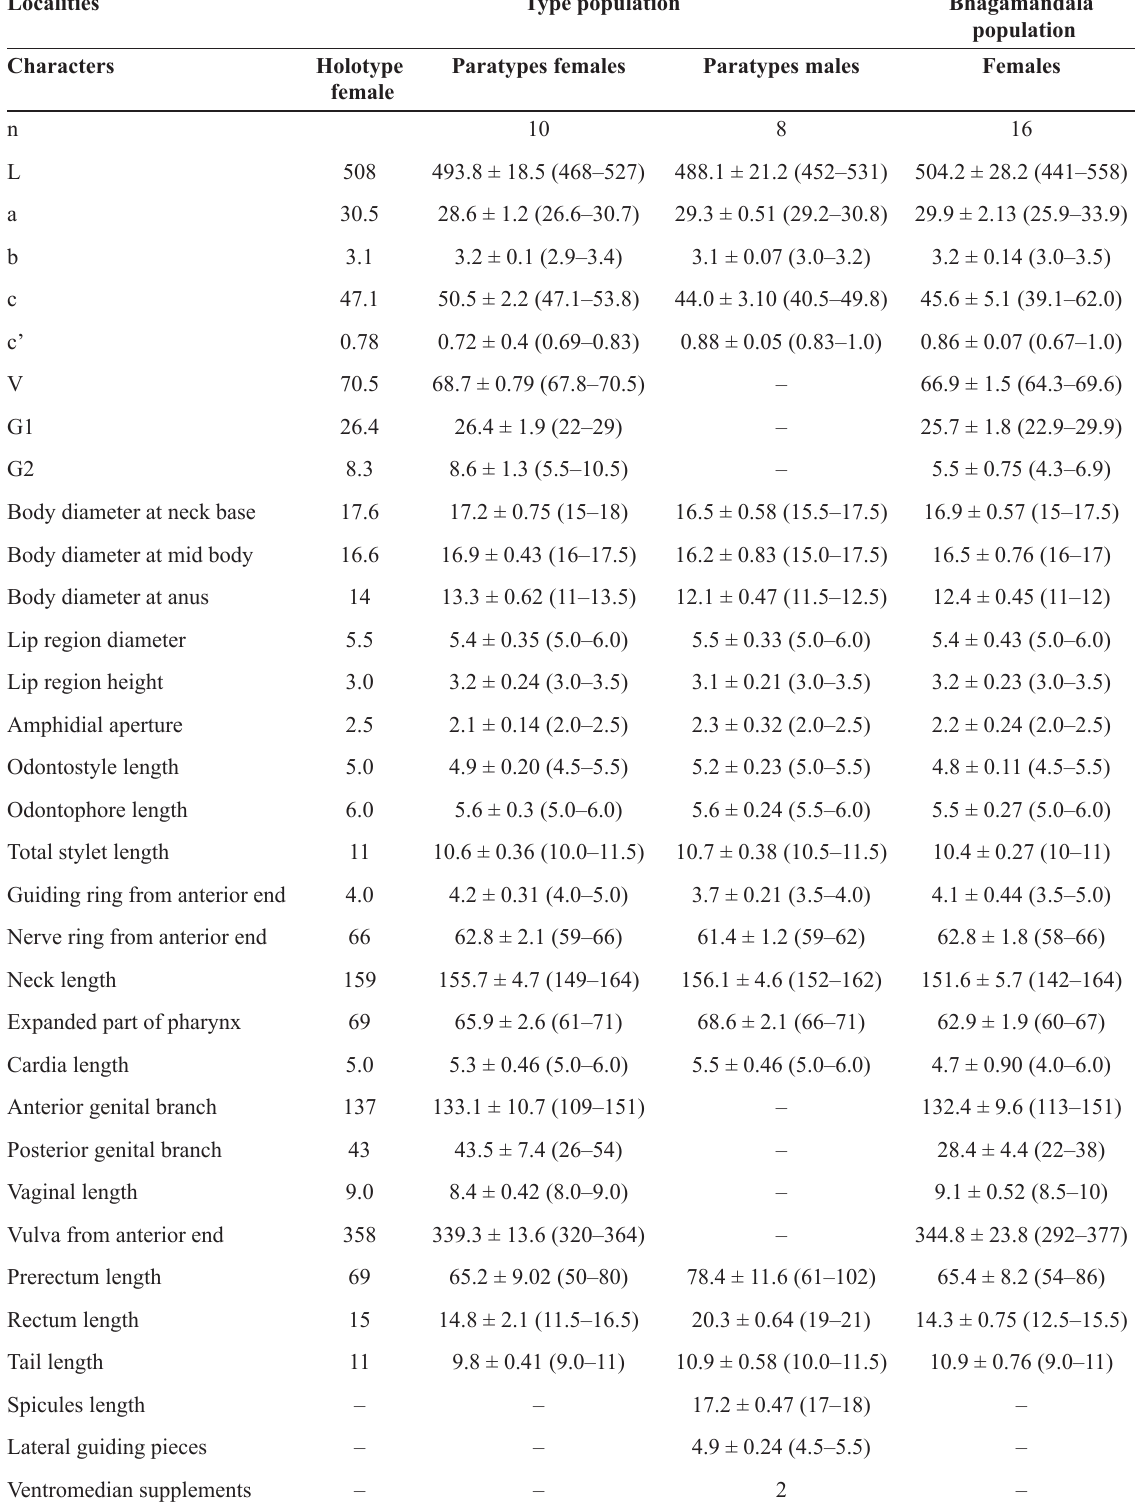
Table 8. Measurements of Tylencholaimus southindicus sp. nov. All measurements are in µm and in the form: mean ± s.d.